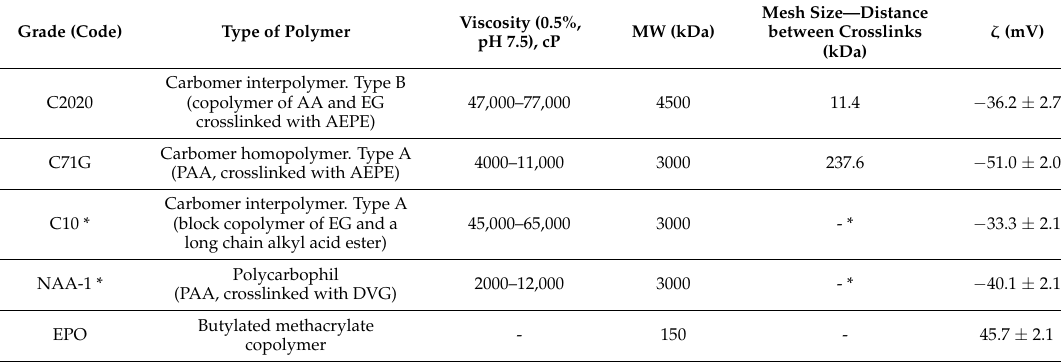
Table 1. Physicochemical characteristics as specified by Evonik (healthcare.evonik.com) for Eudragit ® E PO (EPO) and Lubrizol Advanced Materials (lubrizol.com) for polycarbophil and different grades of carbomer used to prepare interpolyelectrolyte complex (IPEC). (Abbreviation: